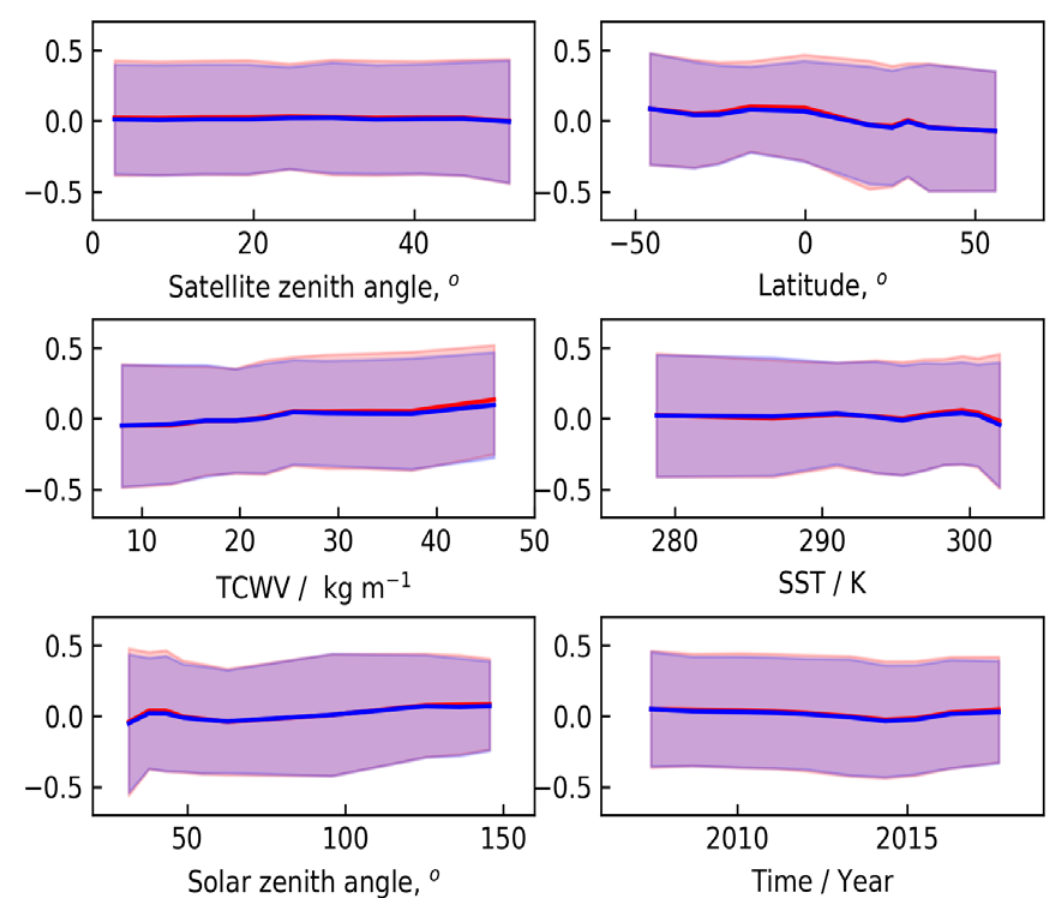
Figure 4. Dependence plots of satellite-minus-in-situ differences, calculated for deciles of independent quantities (~9500 matches in each decile): top left—satellite zenith angle; top right—latitude; middle left—total column water vapor; middle right—prior sea surface temperature; lower left—solar zenith angle at satellite observation time; lower right—time of observation in calendar years. Red line: mean difference for MTA SSTs using OE parameters harmonized against AATSR; red shading: corresponding standard deviation. Blue line: mean difference for MTA SSTs using optimal estimation (OE) parameters harmonized against SLSTR; blue shading: corresponding standard deviation.